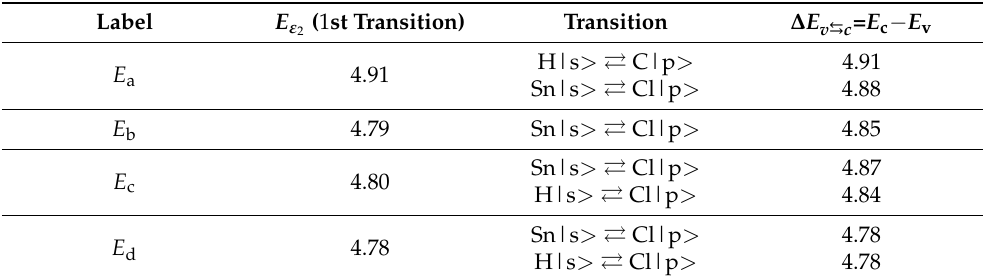
Table 4. The possible first transition and the energy corresponding deduced from the dielectric function and the partial density of states.